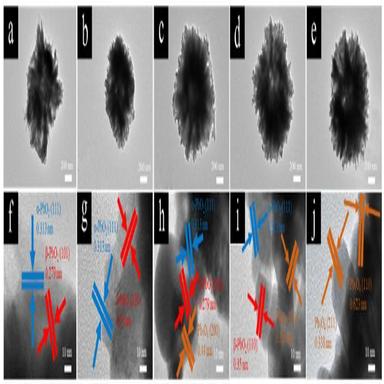
TEM and HRTEM images of (a, f) PbO2-3 h; (b, g) PbO2-12 h; (c, h) PbO2/Pb3O4-36 h; (d, i) PbO2/Pb3O4-48 h; (e, j) Pb3O4.